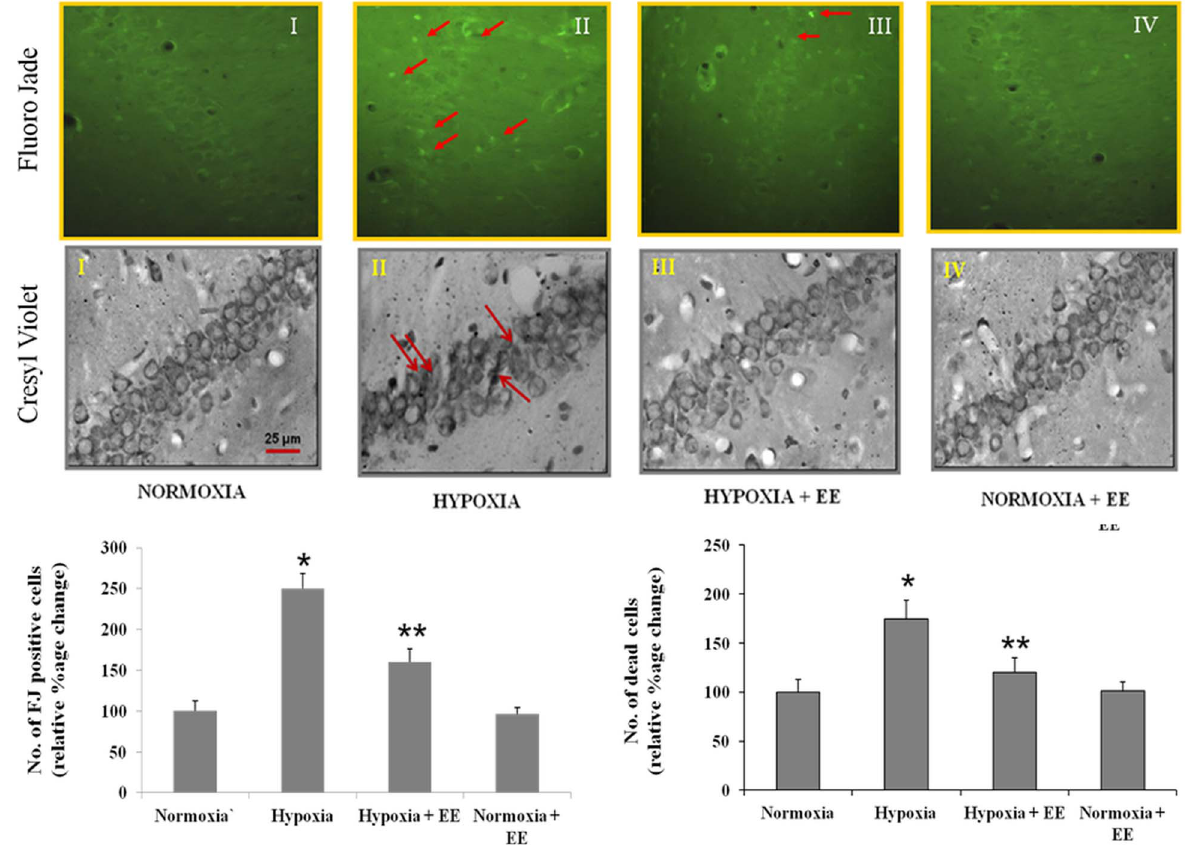
Figure 2. Fluoro Jade (FJ) and Cresyl violet staining, was assessed to study neurodegeneration and cell morphology. It was observed that Hypobaric hypoxia leads to neurodegeneration and cell pyknosis as evident from increased number of FJ positive cells and pyknotic cells whereas enriched environment decreases number when compared to hypobaric hypoxia alone group. Data represents Mean 6 SEM. ‘‘ * ’’ and ‘‘ ** ’’ represents p , 0.001 when compared to control and hypoxic group.